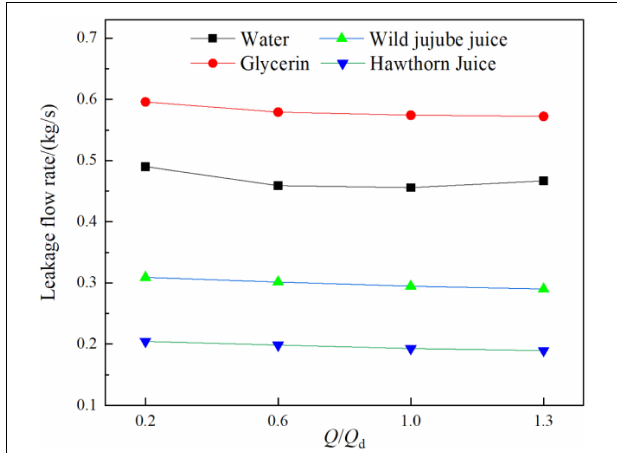
FIGURE 14 | Leakage of the front cavity of a centrifugal pump with different viscosities.